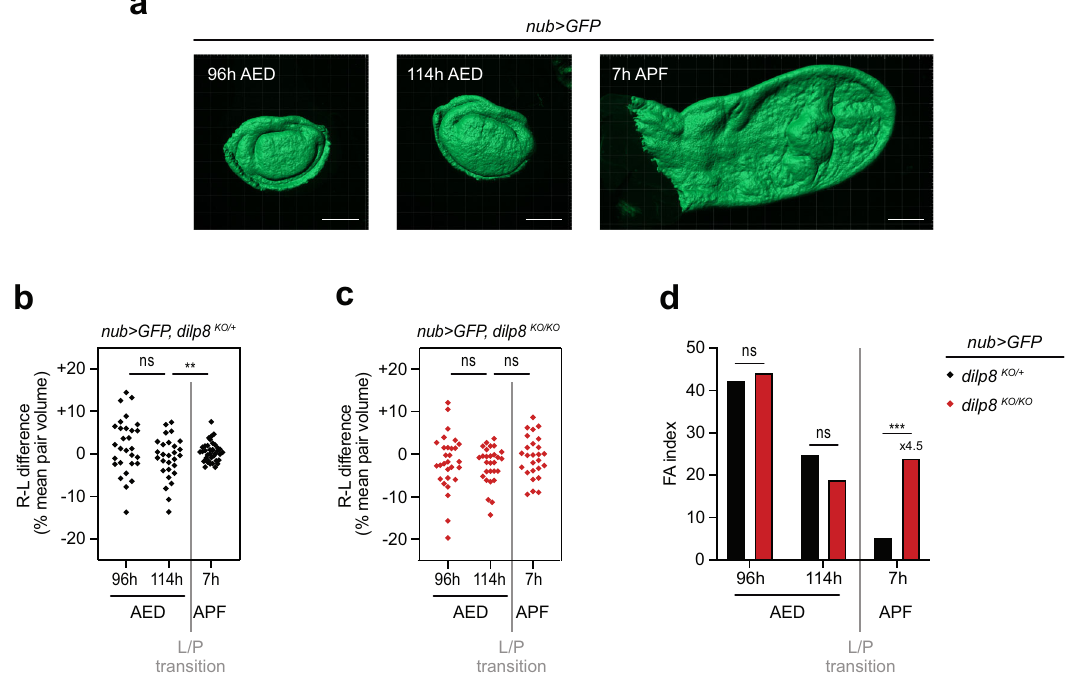
Fig. 1 | A developmental time window for organ size adjustment. a Representative examples of surface reconstruction for volume measurements of the wing pouch domain labeled with nub > GFP at 96h AED (mid L3 stage), 114h AED (late L3 stage), and 7h APF (early pupal stage). Scale bars represent 100 μ m. Thesereconstructionswererepeatedeachtimeforthennumbersindicatedbelow. b Distribution of the right-left (R-L) pouch volume differences measured for indi- vidualpairsofwingdiscsandexpressedasthepercentageofthemeanpairvolume in control dilp8 heterozygous animals ( nub > GFP, dilp8 KO/+ ). ** p =0.0012, Levene ’ s test. c Distribution of the right-left (R-L) pouch volume differences measured for